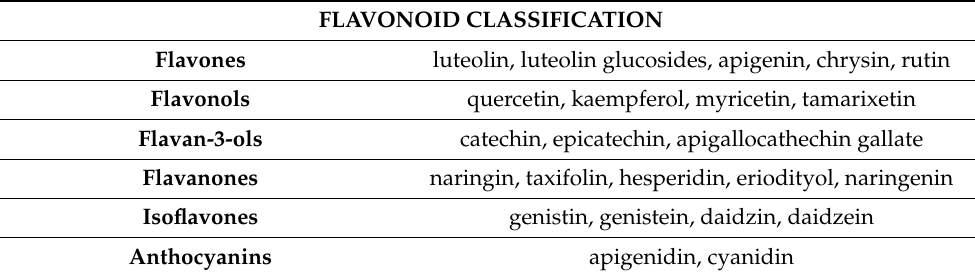
Table 2. Examples of flavonoid compounds divided for each